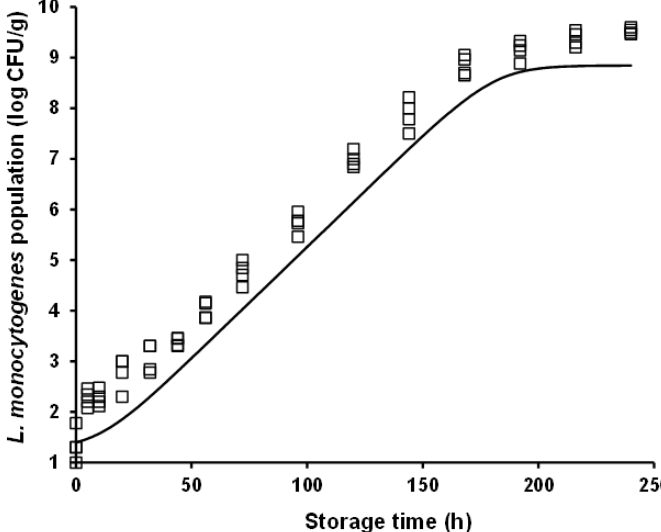
Figure 3. Observed (symbols) and predicted (line) growth of Listeria monocytogenes in battered chicken nuggets during storage at 10 °C.